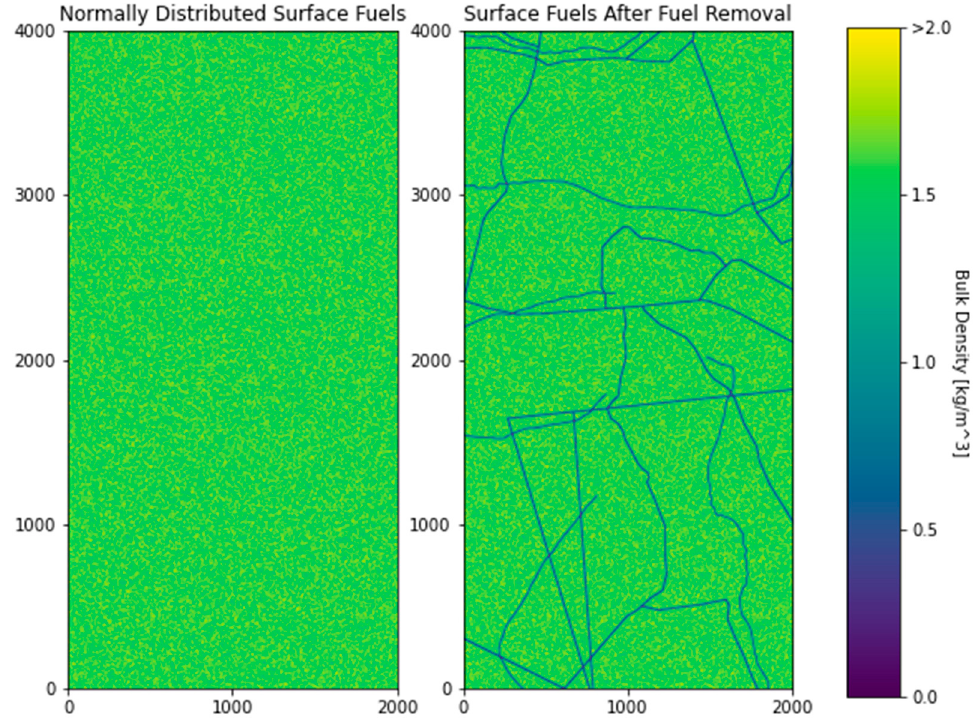
Figure 3. Bulk density of 1 m-tall surface fuel cells before and after fuel break removal.